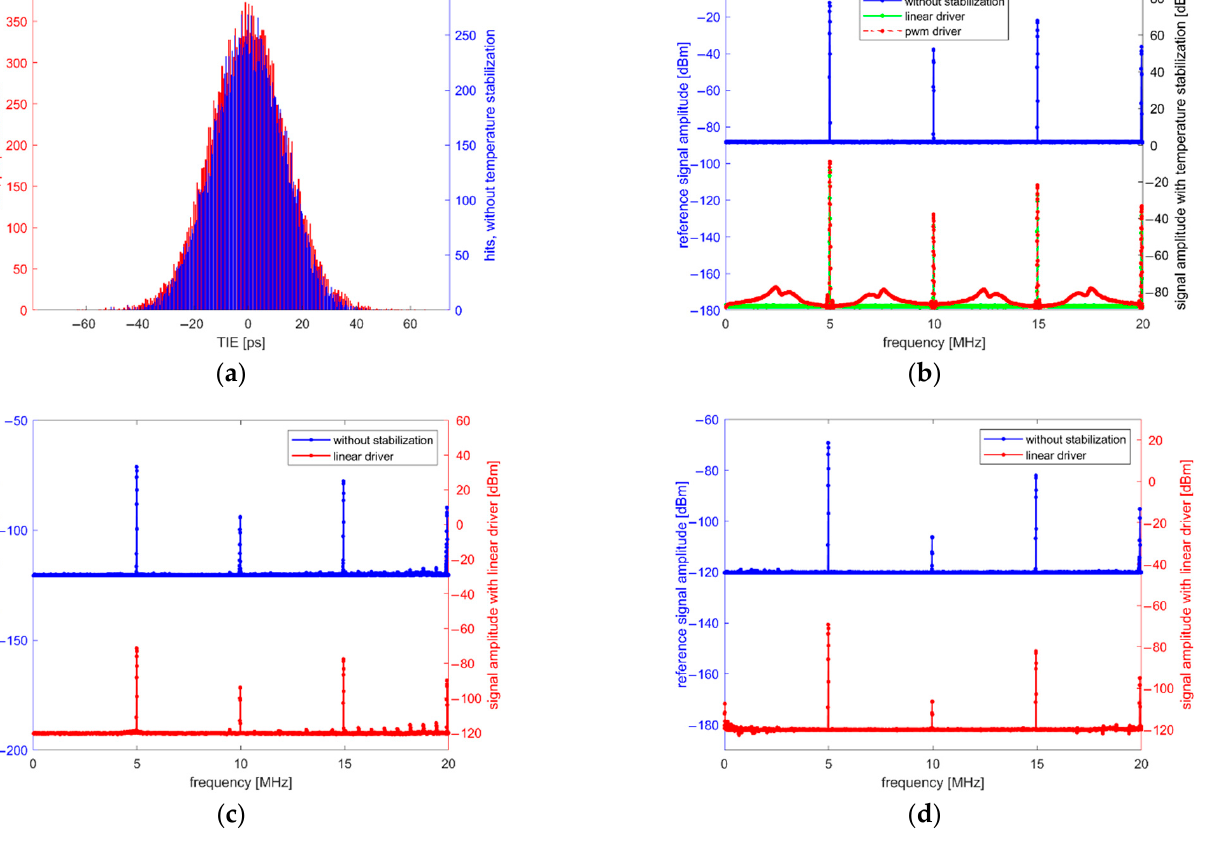
Figure 12. Measurement results with the proposed TEC controller. ( a ) TIE distribution of direct os- cillator output; ( b ) direct oscillator output frequency spectrum; ( c ) electric field frequency spectrum; ( d ) magnetic field frequency spectrum.